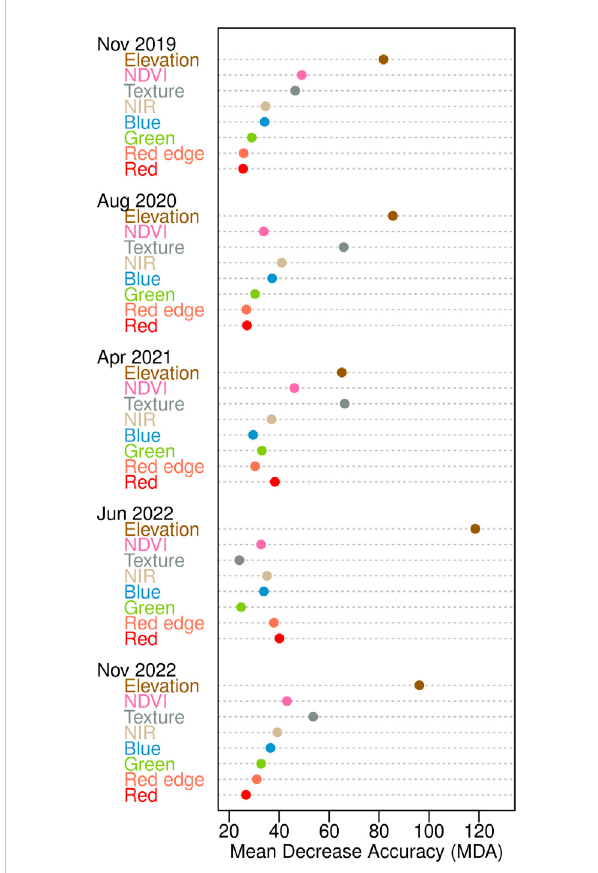
FIGURE 5 Variable importance plots calculated using the mean decrease